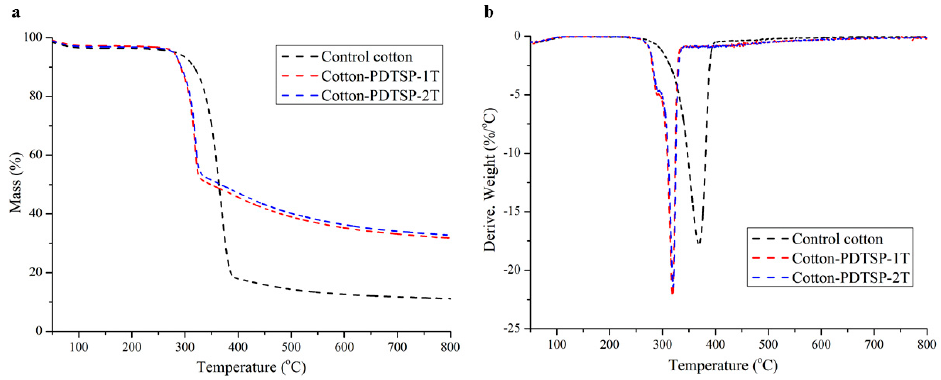
Figure 6. TG ( a ) and DTG ( b ) curves under N 2 atmosphere.